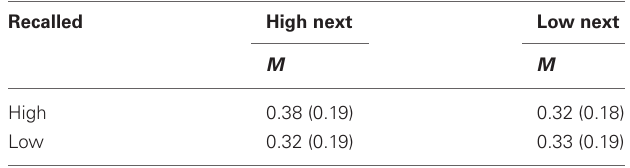
Table 3 | Mean probability of recalling a High vs. a Low NoF word next, given that a High or Low NoF word has just been recalled (standard deviations in parenthesis).